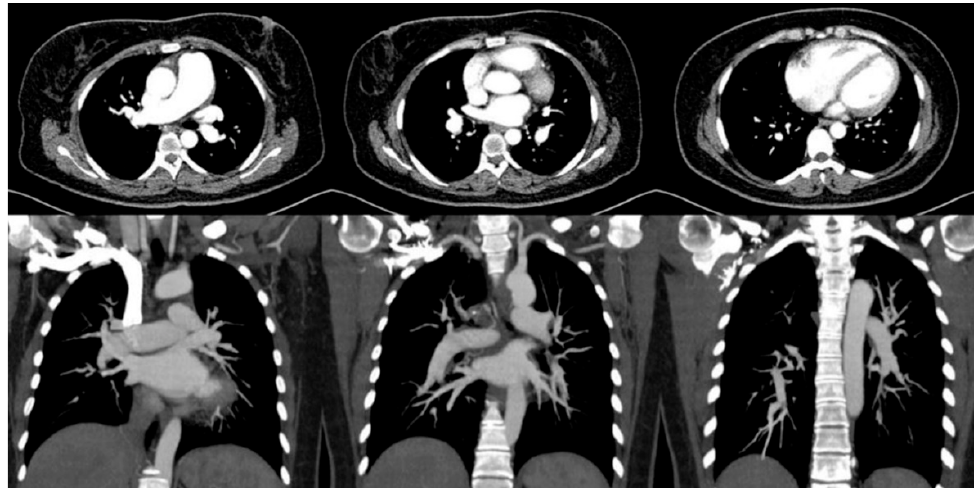
Figure 2. CT findings in the case. CT imaging showed a dilated main PA and a dilated RV but no evidence of PE or lung parenchymal disease. evidence of PE or lung parenchymal disease.